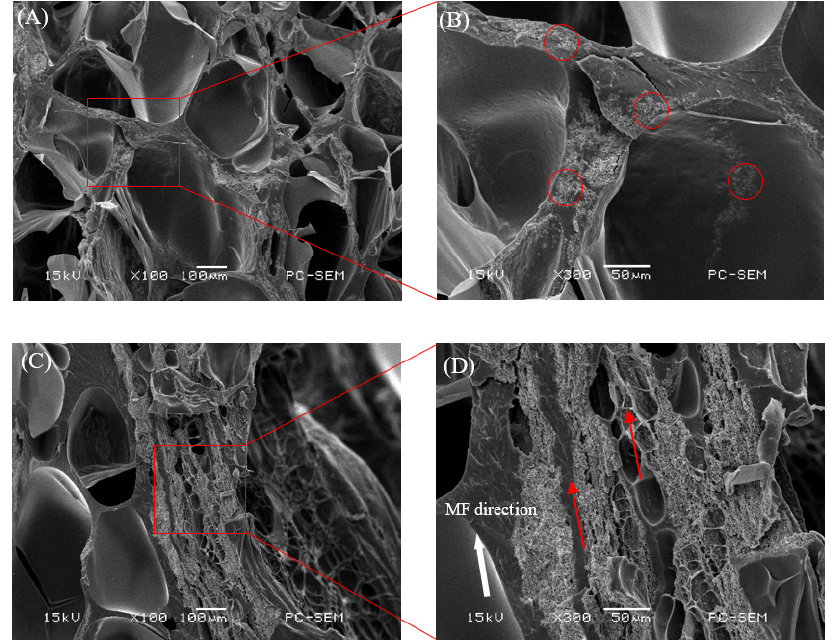
Figure 2. SEM images of cross-section surfaces of the freeze-dried magnetic hydrogels with 2 vol% Fe3O4. ( A ) isotropic sample; ( B ) magnification of the red rectangular area in ( A ); ( C ) anisotropic sample; ( D ) magnification of the red rectangular area in ( C ).